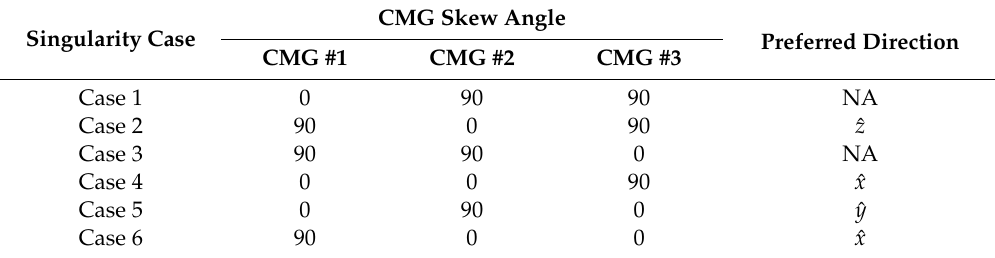
Table 2. Mixed skew angles in the literature and resulting preference dictions